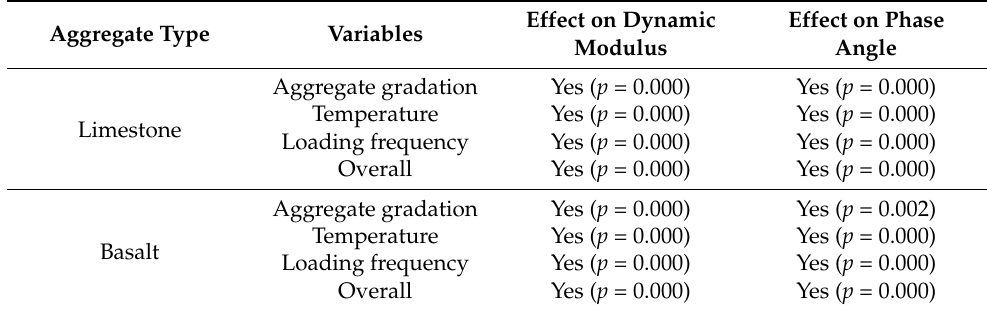
Table 4. Statistically significant effect of the aggregate gradation in the dynamic modulus and phase